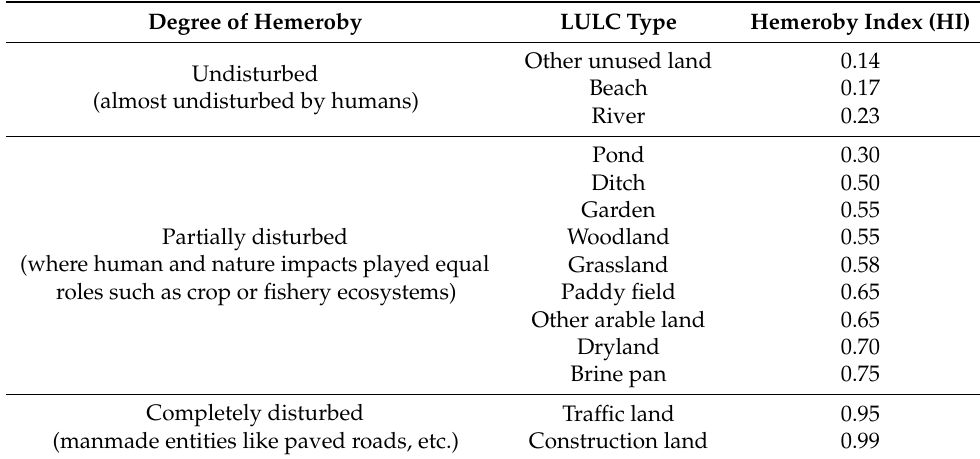
Table 3. Hierarchy of the LULC type with respect to the hemeroby index (HI). Degree of Hemeroby LULC Type Hemeroby Index (HI) Other unused land 0.14 Undisturbed Beach 0.17 (almost undisturbed by humans) River 0.23